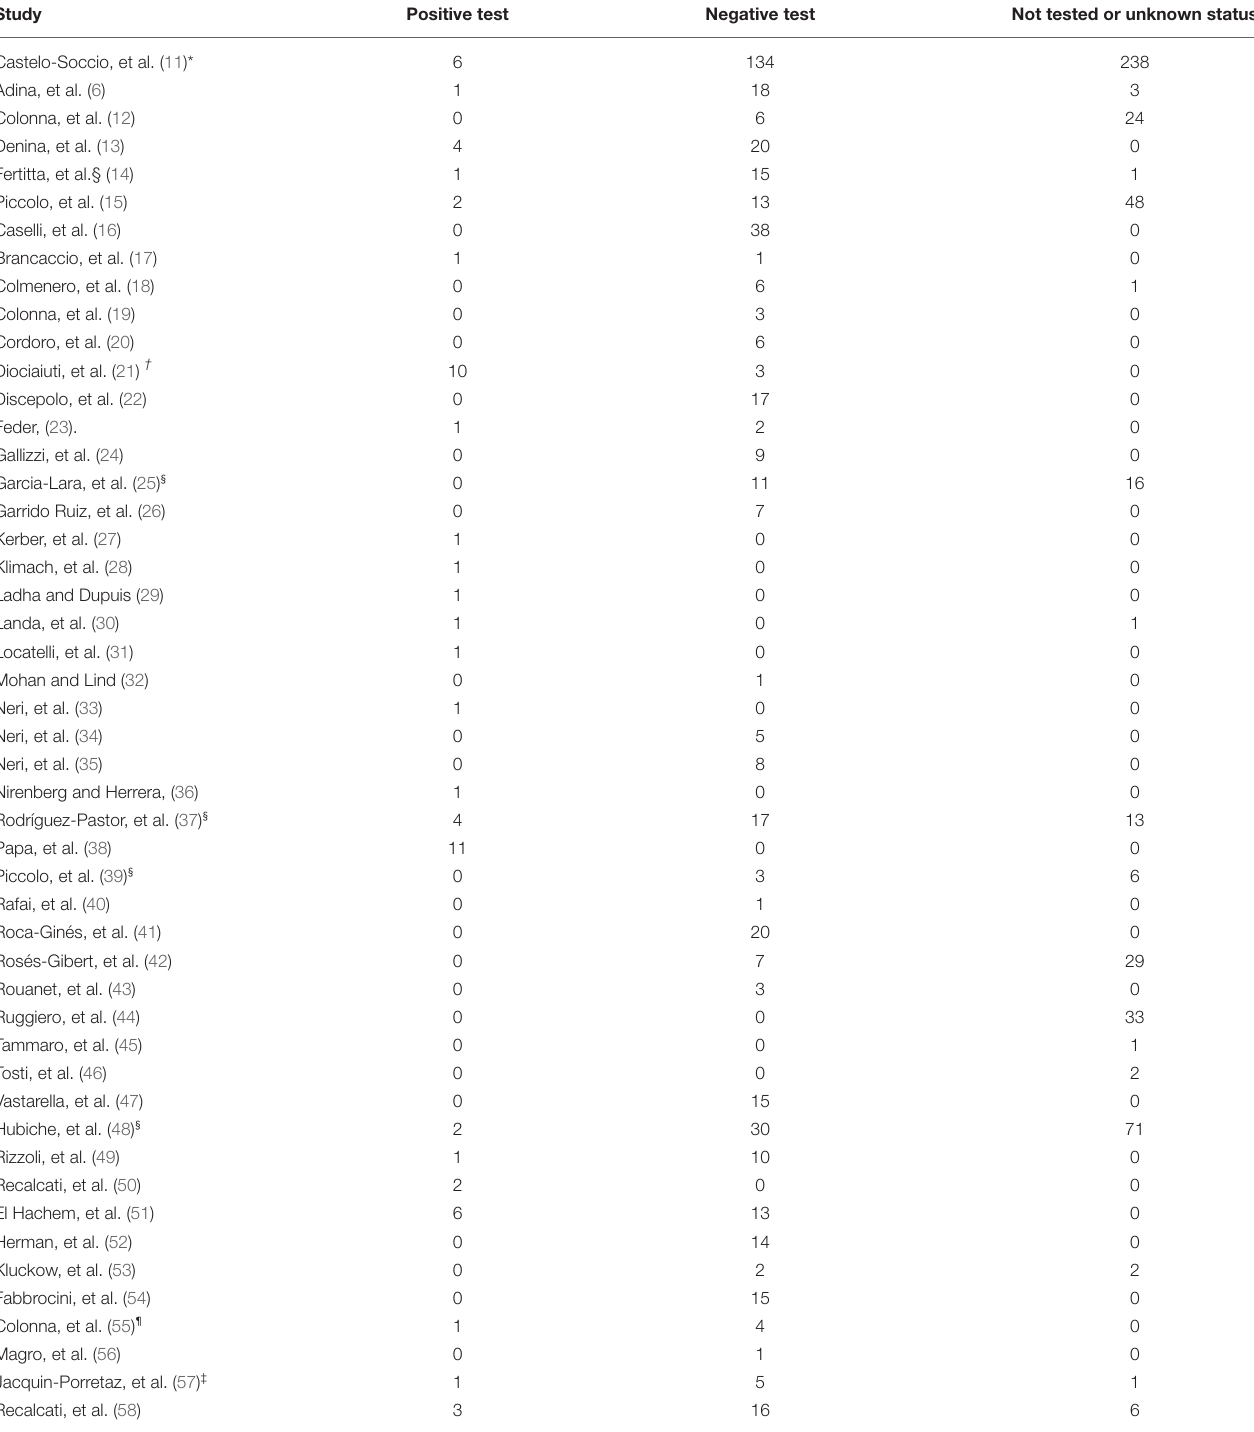
TABLE 2 | SARS-CoV-2 infection status by serology or PCR testing.